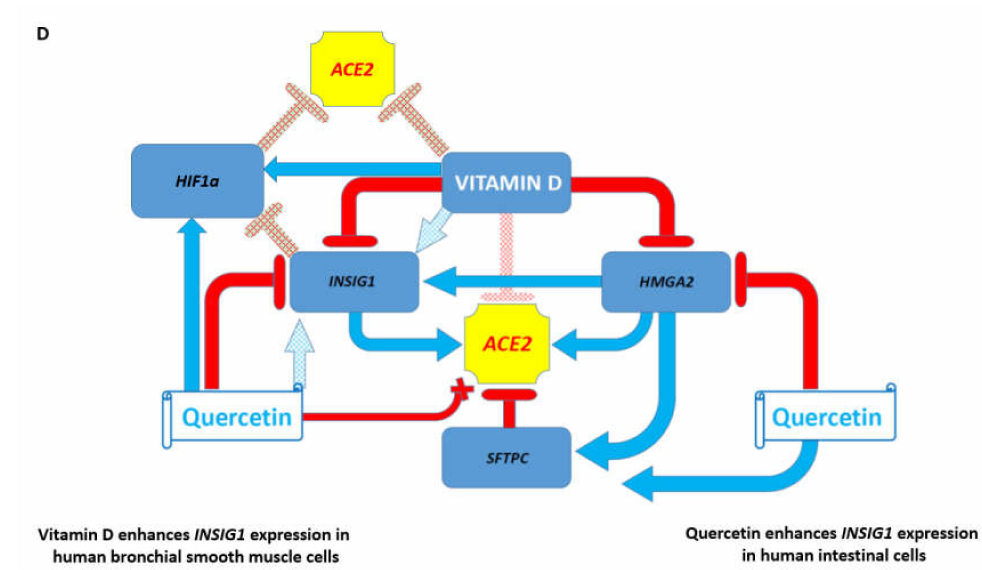
Figure 6. E ff ects of the VDR gene, vitamin D, and quercetin on pathways and genes a ff ecting the newly emerged SARS-CoV-2 virus-related host targets. ( A ) E ff ects of the VDR gene, vitamin D, and quercetin on repressors of the ACE expression. ( B ). E ff ects of the VDR gene, vitamin D, and quercetin on activators of the ACE expression. ( C ). E ff ects of the VDR gene, vitamin D, and quercetin on repressors of the ACE expression reflecting GATA5 inhibitory e ff ects on SFTPC expression in the mouse lungs. ( D ). E ff ects of the VDR gene, vitamin D, and quercetin on activators of the ACE expression reflecting the cell type-specific e ff ects of vitamin D and quercetin: vitamin D-induced activation of the INSIG1 expression in human bronchial smooth muscle cells and quercetin-induced activation of the INSIG1 expression in human intestinal